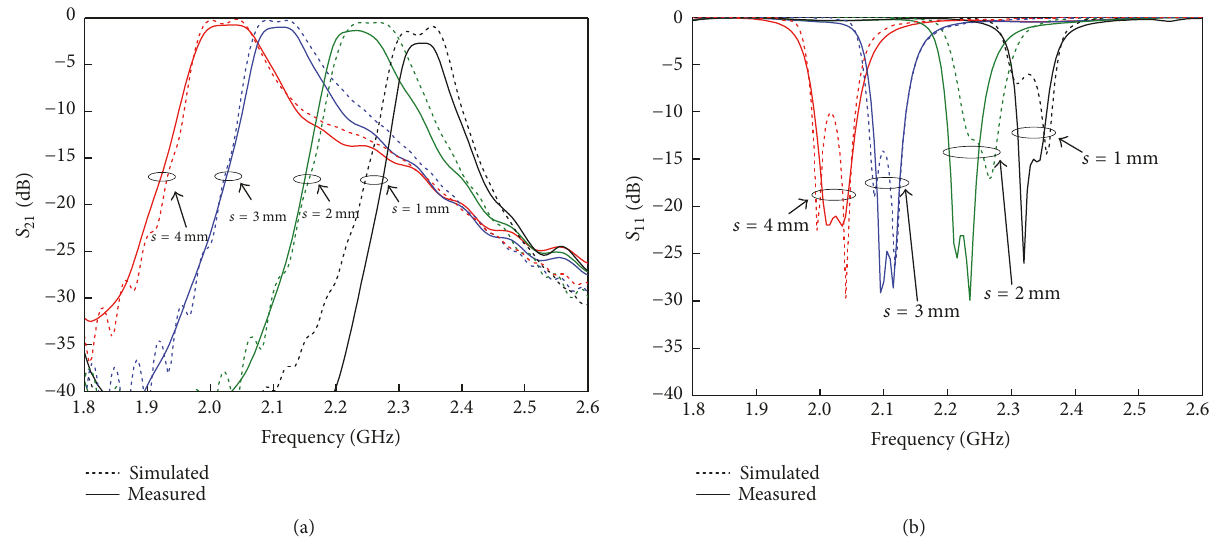
Figure 9: Simulated and measured results for adjusting the gap between SRR and end of tuning screw: (a) reflection coefficient ( S 11) and transmission